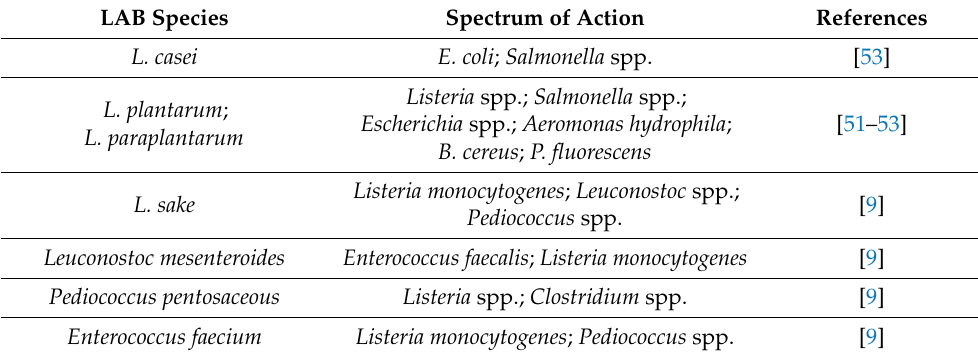
Table 2. Lactic acid bacteria used against foodborne pathogens in the food